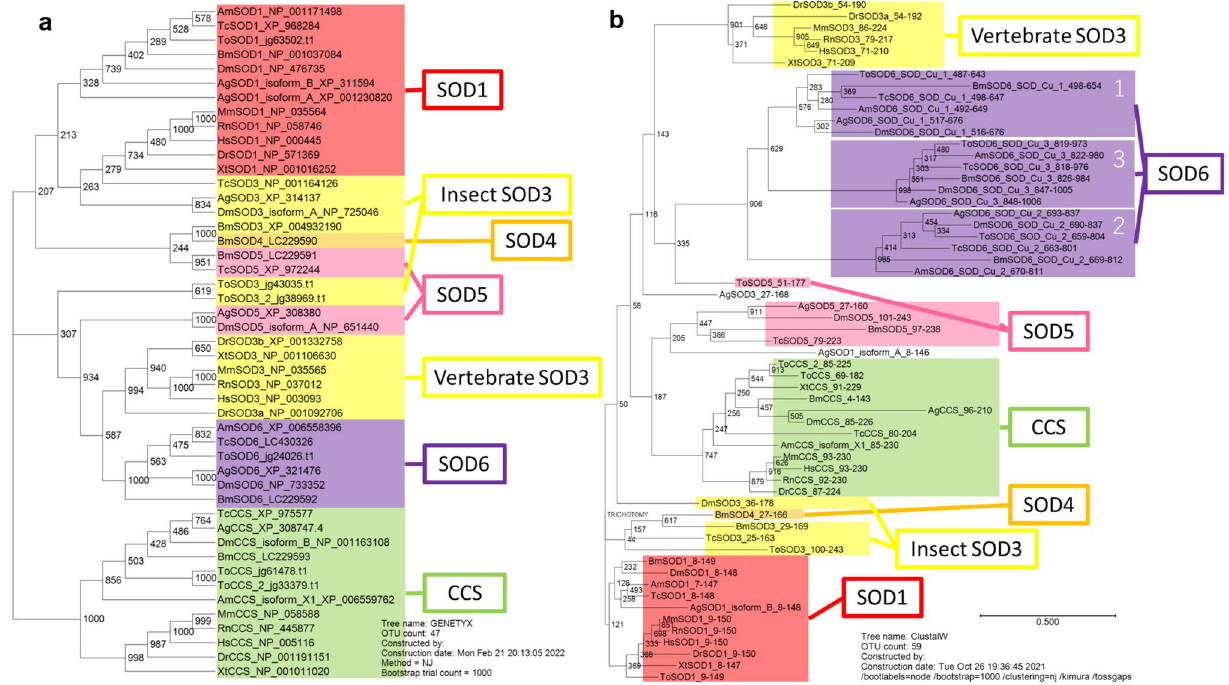
Figure 2. Phylogenetic analysis of superoxide dismutases. ( a ) A phylogenetic tree of six types of Tribolium castaneum superoxide dismutases (SOD) and SOD proteins of other species. ( b ) A phylogenetic tree of SOD_ Cu/Zn domains in T. castaneum and other species. The amino acid sequences of the SODs used in this study are presented in Supplementary Tables 1 and 2. The SOD gene name of each animal is presented as the acronym